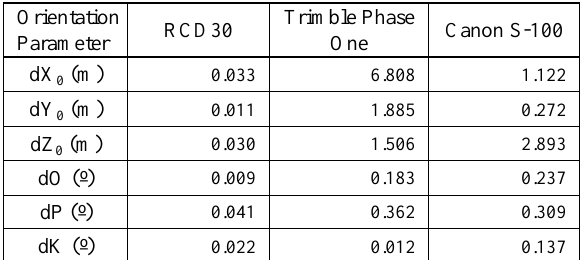
Table 6. External orientation parameters (Combined with